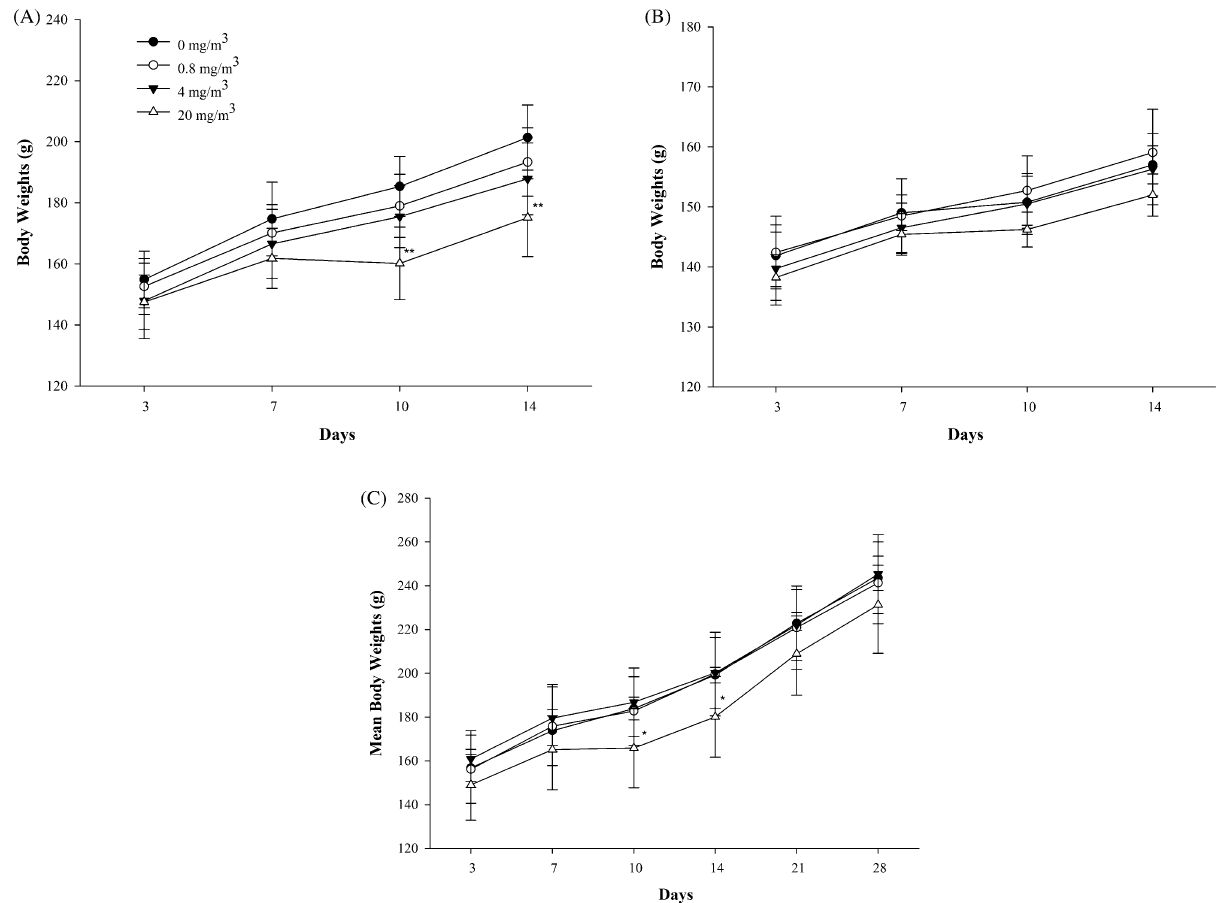
Figure 2. Changes of body weights in the rats exposed to NaDCC. Males ( A ) and Females ( B ) of the main groups, Males ( C ) of the recovery groups. Significantly different from control by Dunnett LSD test: *p < 0.05; **p <